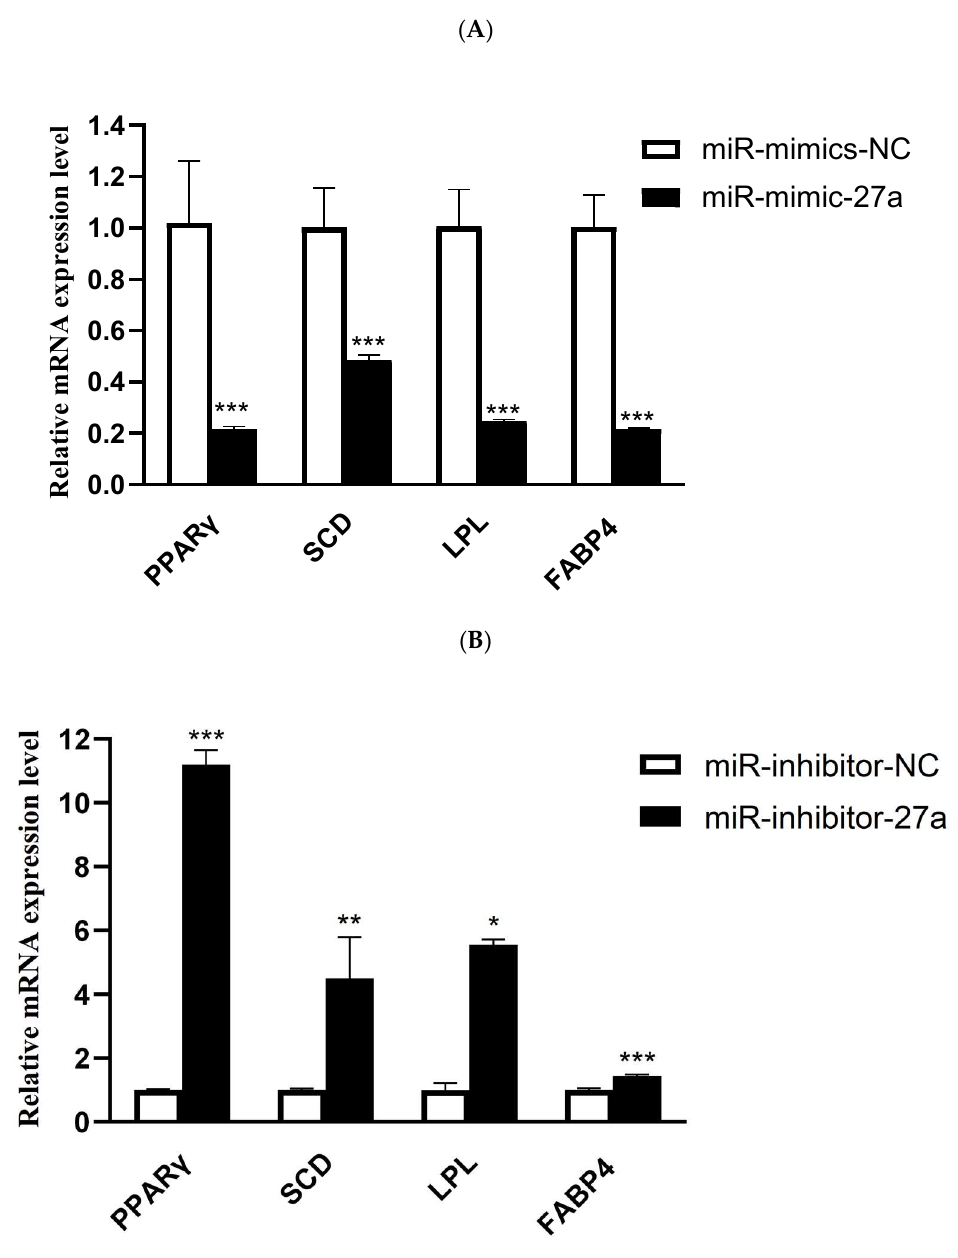
Figure 4. Effect of miR-27a on expression of genes related to lipid metabolism. ( A ) Ovine preadipocytes transfected with miR-27a mimic; ( B ) ovine preadipocytes transfected with miR-27a inhibitor. *** p < 0.001.